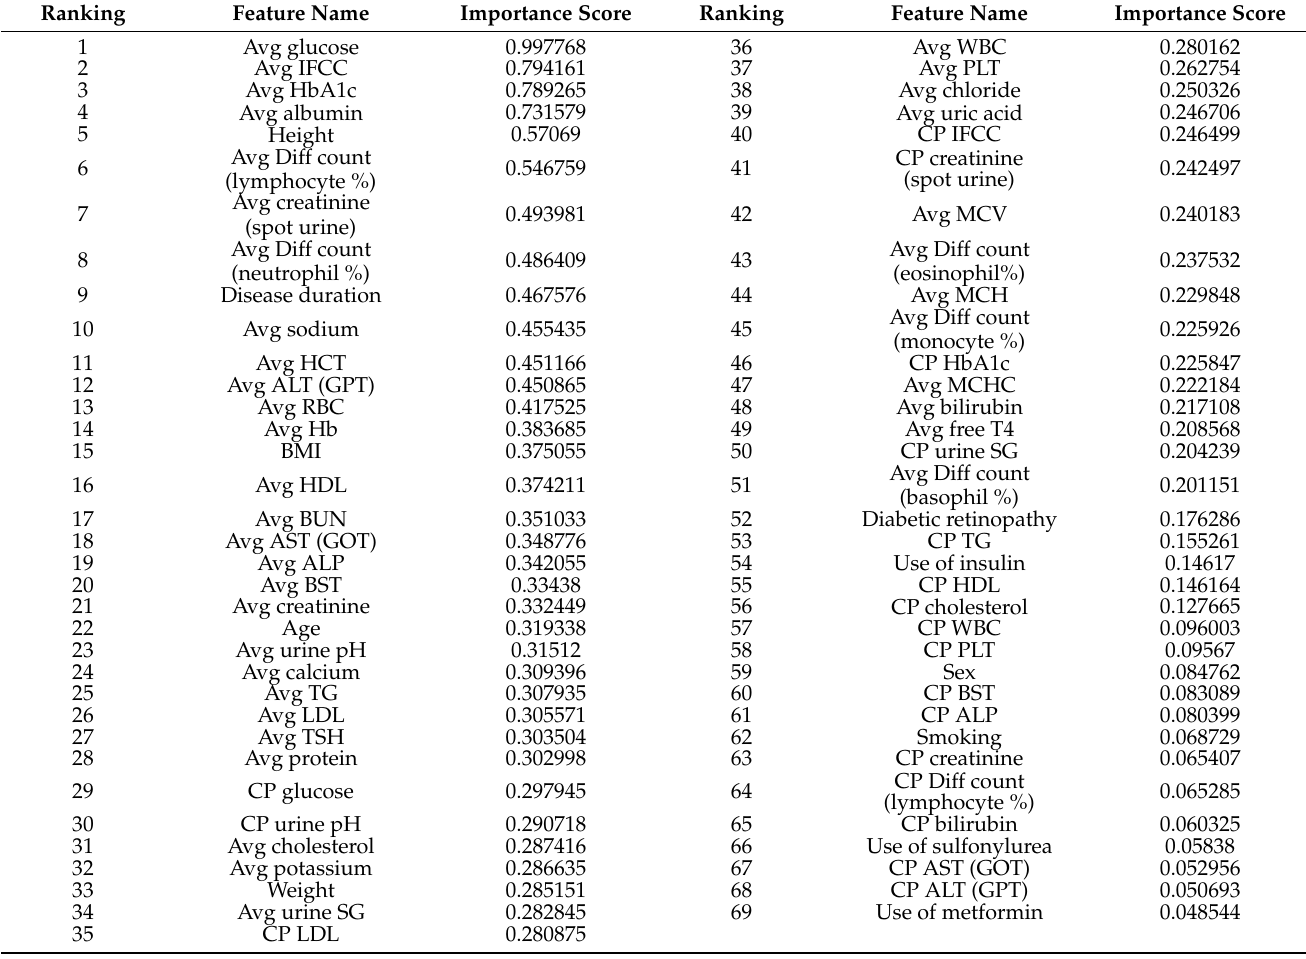
Table 5. Top 69 influential features in the classification of the combination of the normal, possible, and probable groups versus the confirmed